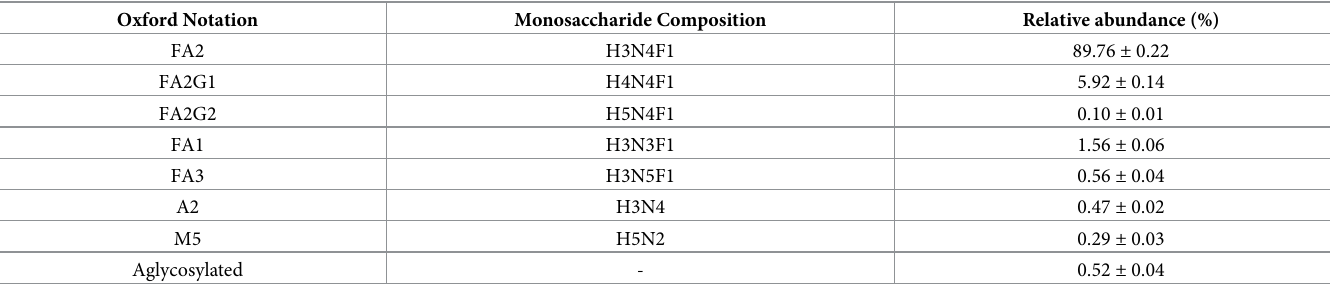
Glycan relative abundances are represented as average ± standard deviation. Monosaccharide composition legend: H = Mannose/Galactose; N = N-Acetylglucosamine; F =